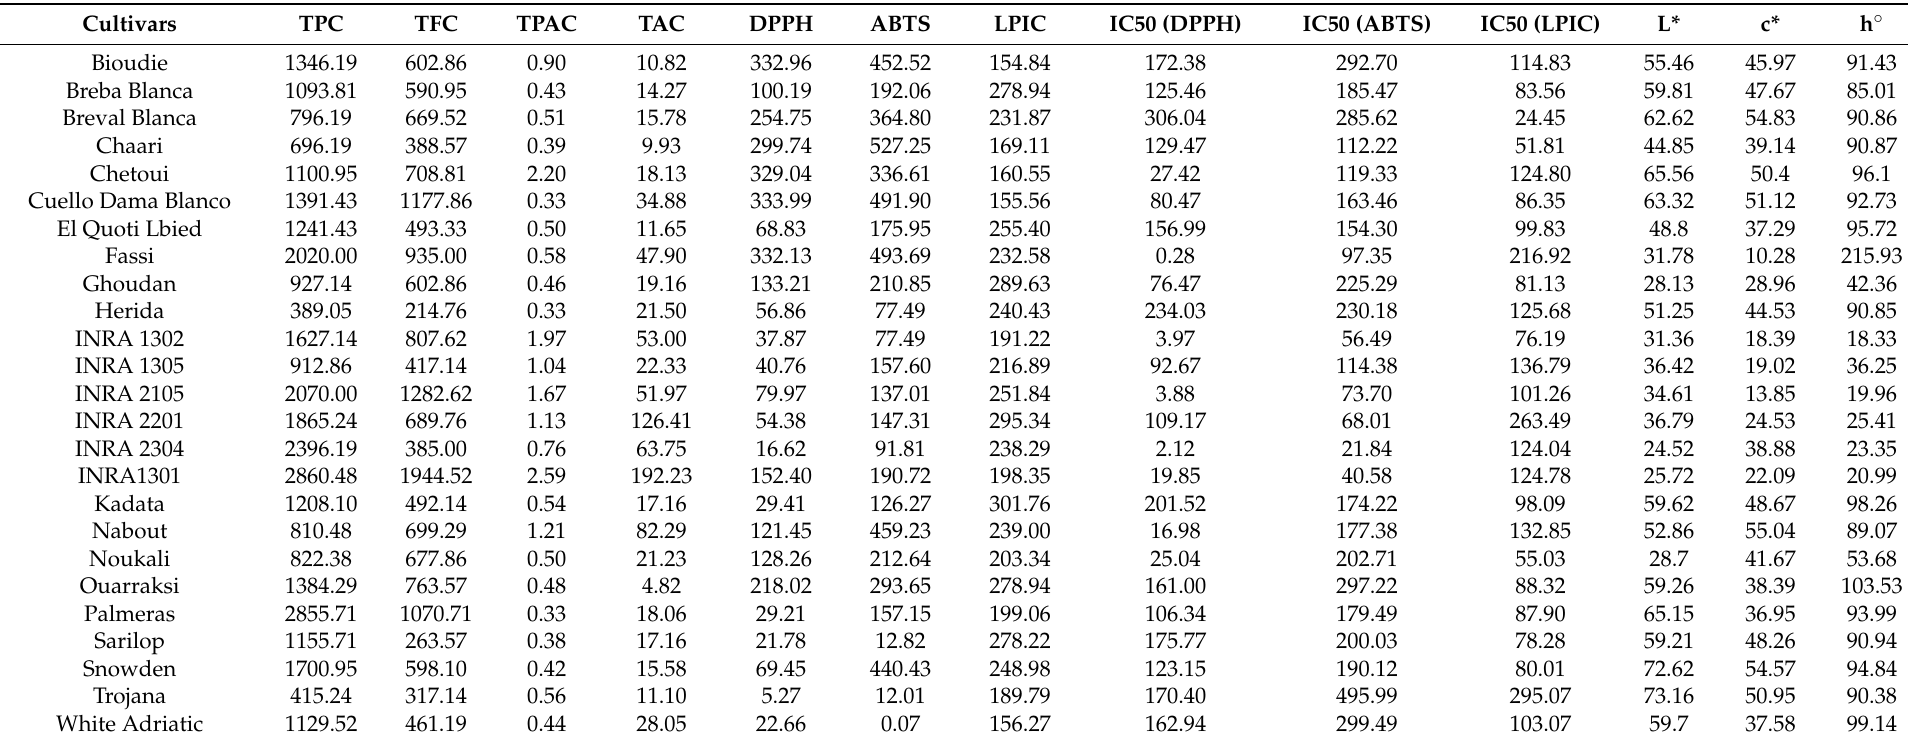
Table 2. Total phenols, flavonoids, anthocyanins, proanthocyanidins, antioxidant activity and chromatic coordinates of fig